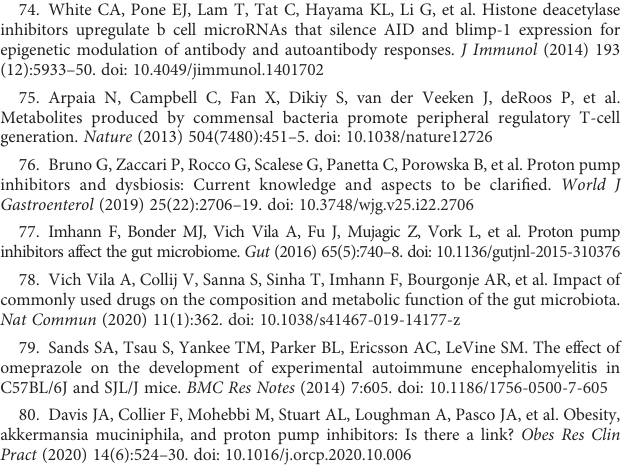
algorithme au sein d ’ un service de me ́ decine interne [Evaluation of the implantation of a de-prescribing process for proton pump inhibitor (PPI) using an algorithm within